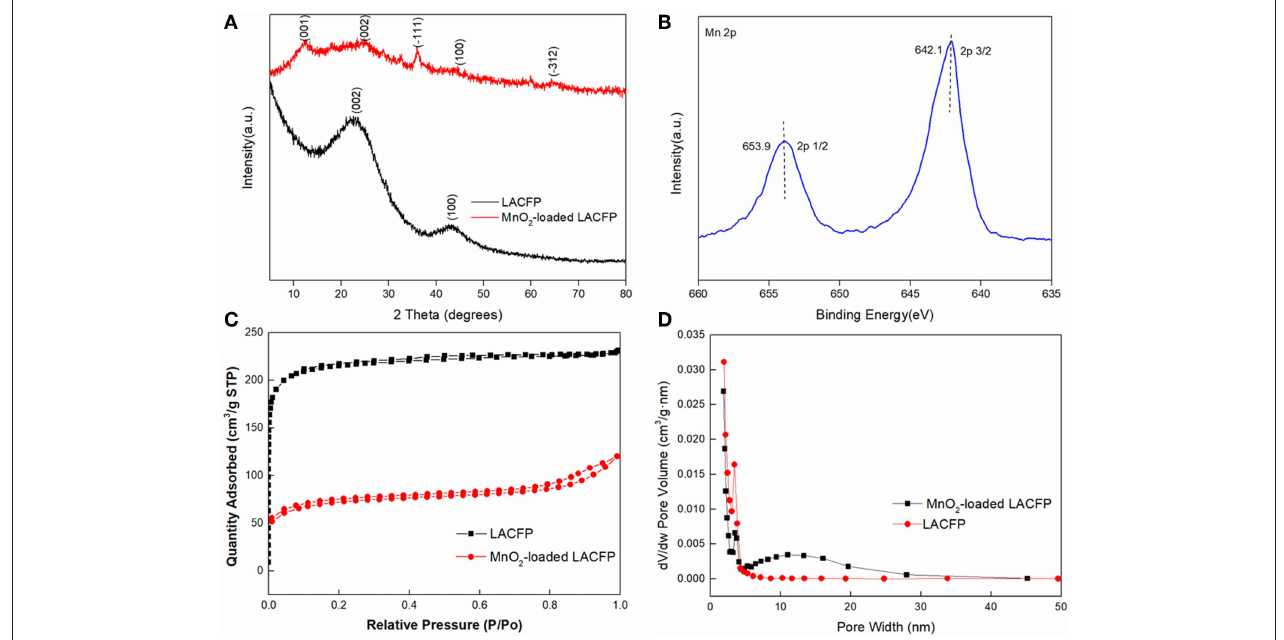
FIGURE 7 | Characterization of LACFP and MnO 2 -loaded LACFP [XRD patterns (A) ; Mn 2p XPS spectra (B) ; N 2 adsorption–desorption isotherms obtained at 77K (C) ; and size distribution (D) ].